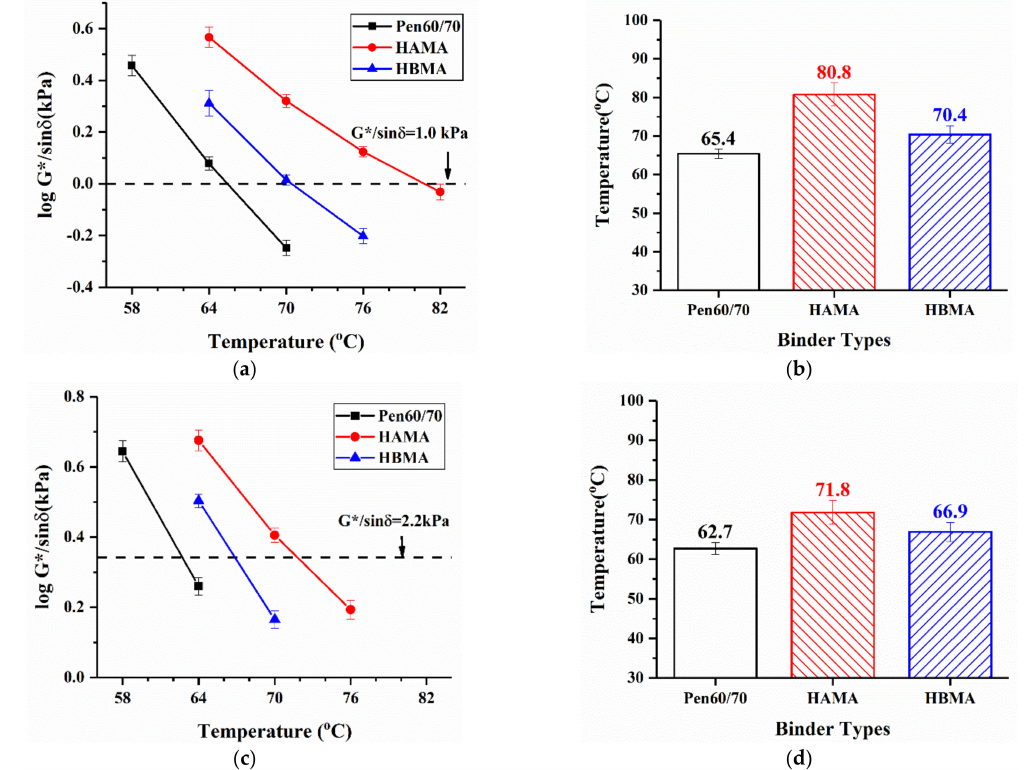
Figure 7. Temperature sweep test results: ( a ) rutting factor (unaged); ( b ) failure temperature (unaged); ( c ) rutting factor (short-term-aged); and ( d ) failure temperature (short-term-aged).